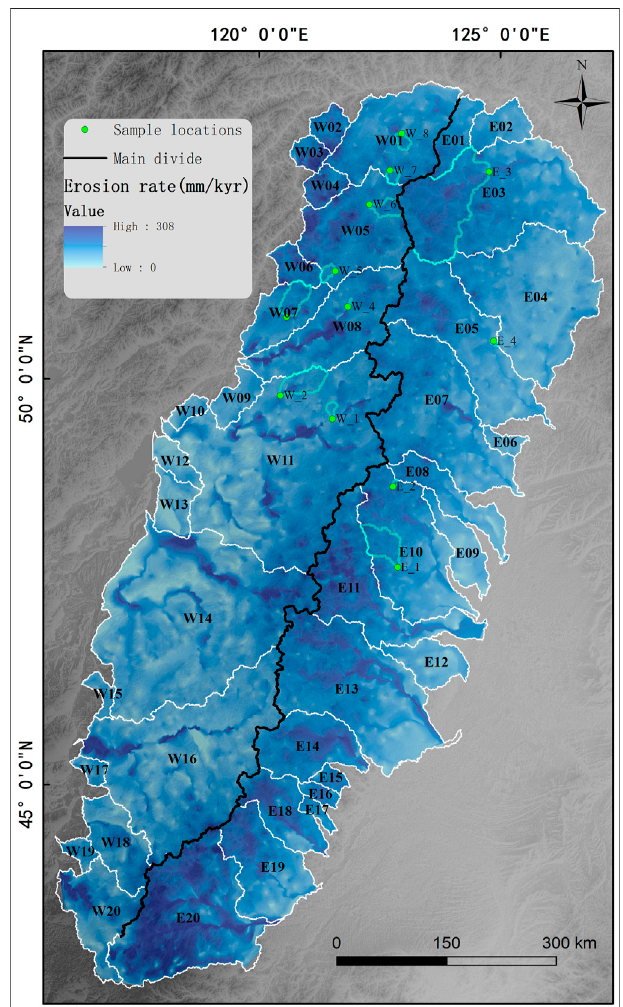
FIGURE 6| Erosion rate of the Greater Khingan Mountains, basin colors show erosion rates calculated from channel steepness, green lines are basin boundaries and dots are sample locations. Black lines are the main drainage